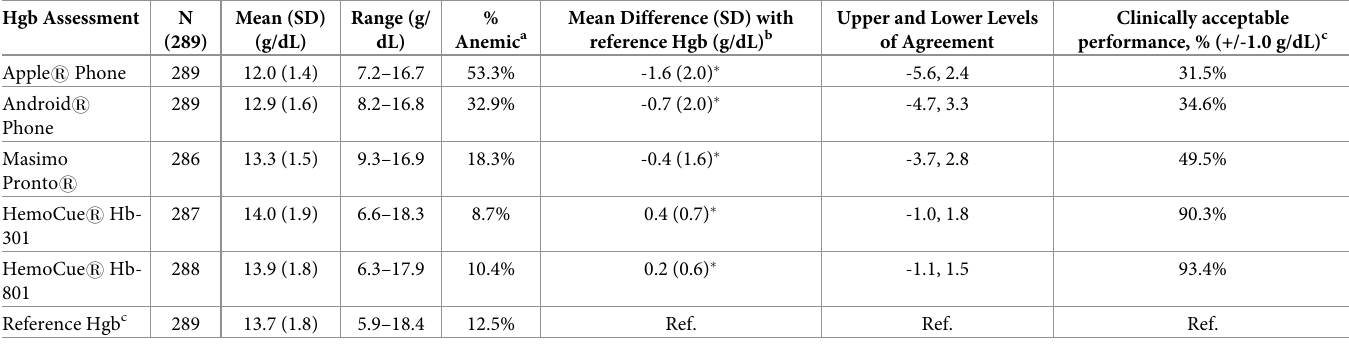
Table 2. Accuracy of hemoglobin assessment devices compared to reference